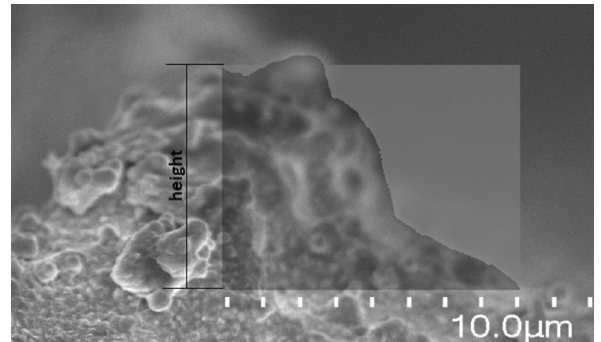
Figure 7. SEM micrograph of the cross-section profile obtained in the side view of the printed sample, with the additional image processing analysis used for the calculation of the effective profile of the printed path.